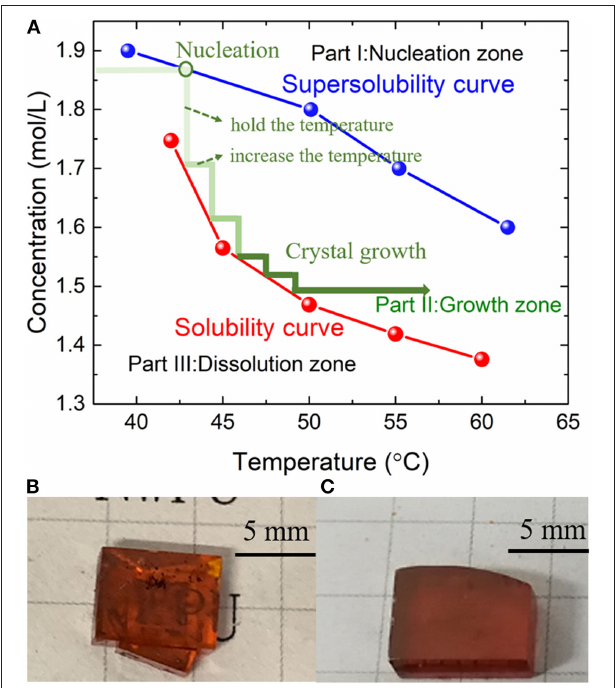
FIGURE 1 | (A) Solubility and supersolubility curves for MPB:I crystal (three zones are divided by the two curves). (B) The as-grown crystals by traditional ITC method. (C) The as-grown crystals by MITC method.